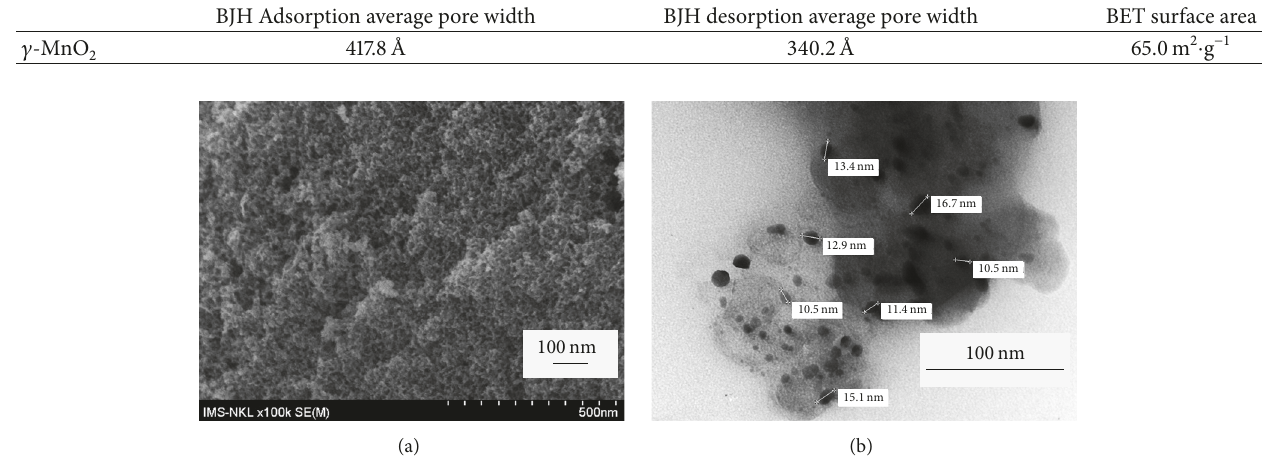
Figure 3: SEM (a) and TEM (b) images of the 𝛾 -MnO 2